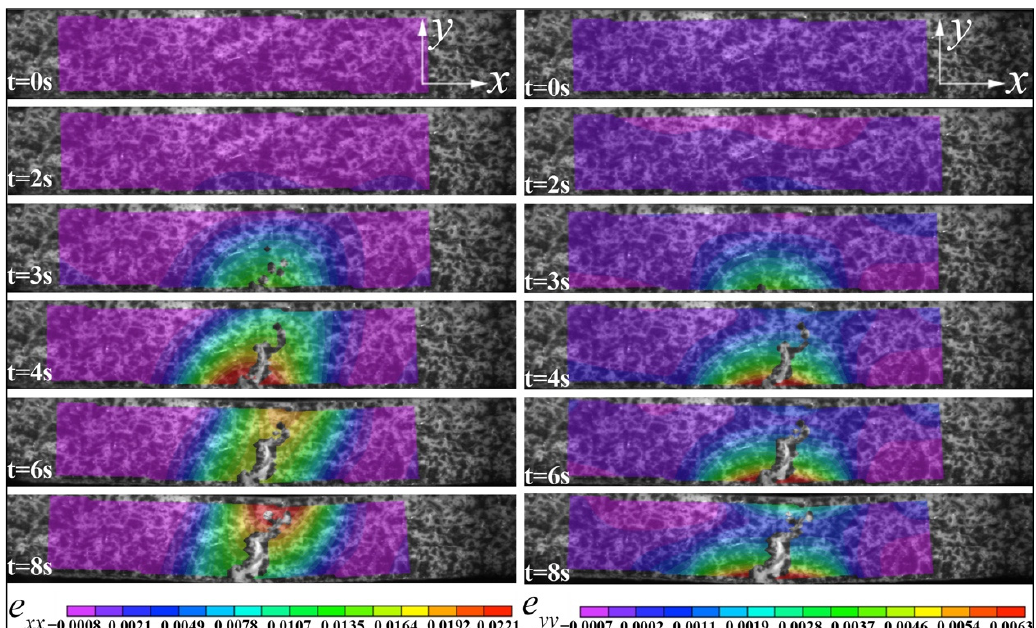
Figure 9. The DIC images of the horizontal strain ( e xx ) and the vertical strain ( e yy ) of ZrO 2 samples under a three-point vertical bending test.